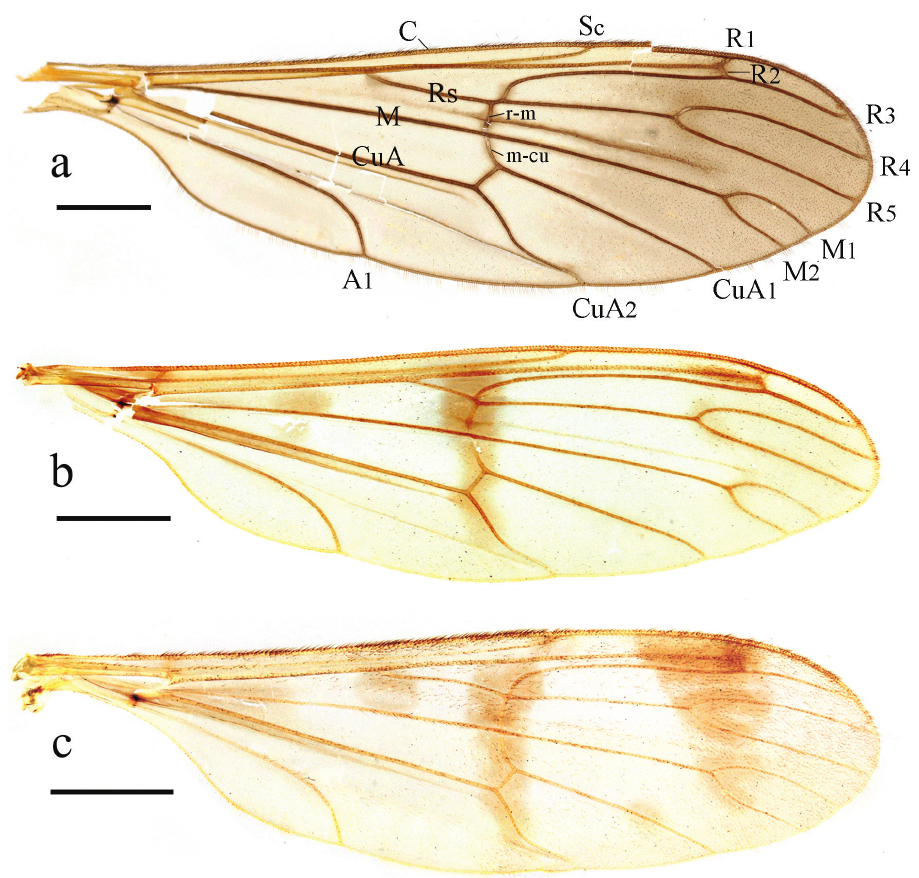
Figure 2. Wings of new Ptychoptera species a P. hekouensis b P. longa c P. xiaohuangshana . Scale bars: 1.0